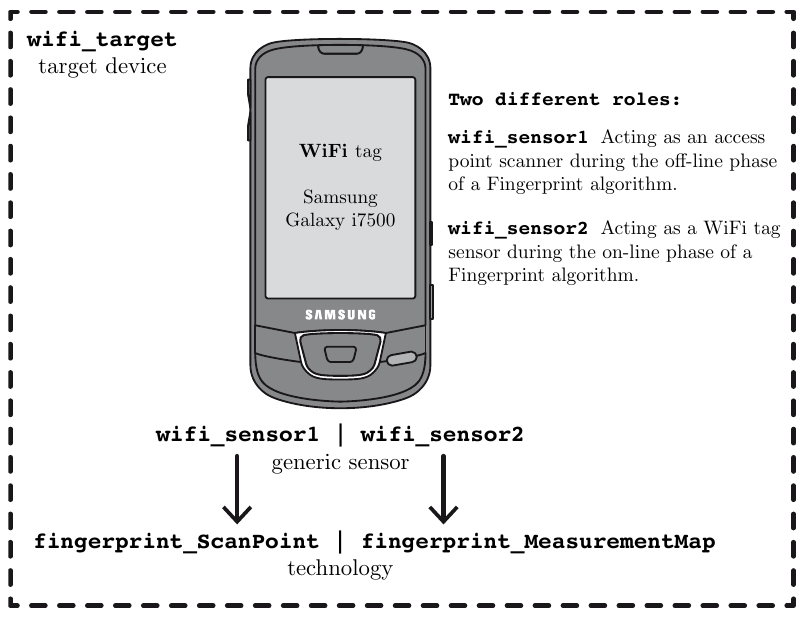
Figure 8. The wifi target represents a target device associated to the wifi sensor1 or wifi sensor2 implemented with the same physical smartphone device, in the example.